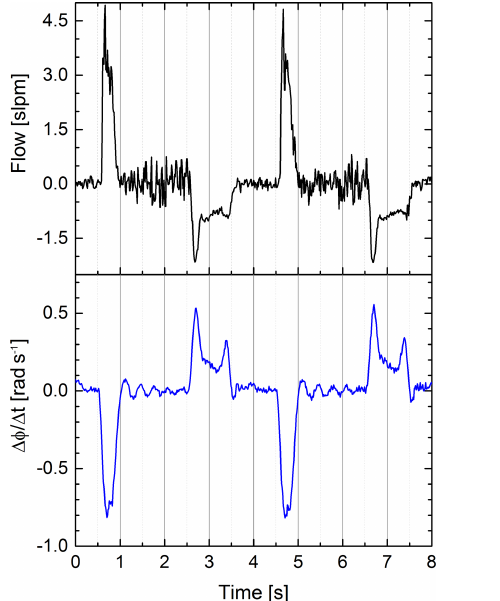
Figure 8. Airflow (black) and differential quotient of the S 21 pa- rameter’s phase at a fixed frequency (blue) vs. time. The differ- ential quotient is clearly more similar to the flow (Pearson coef- ficient = − 0 . 917) than the original phase signal (Pearson coeffi- cient = − 0 . 0134), because both signals are proportional to a volume change. A swinging motion of the balloon causes the slight ringing on the differential quotient after “exhalation” (see signal between second 1 and 2 or between second 5 and